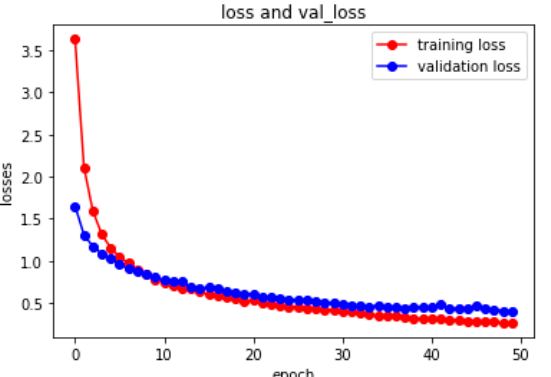
Figure 7. Variation of the loss function for the temporal convolutional network (TCN) model.